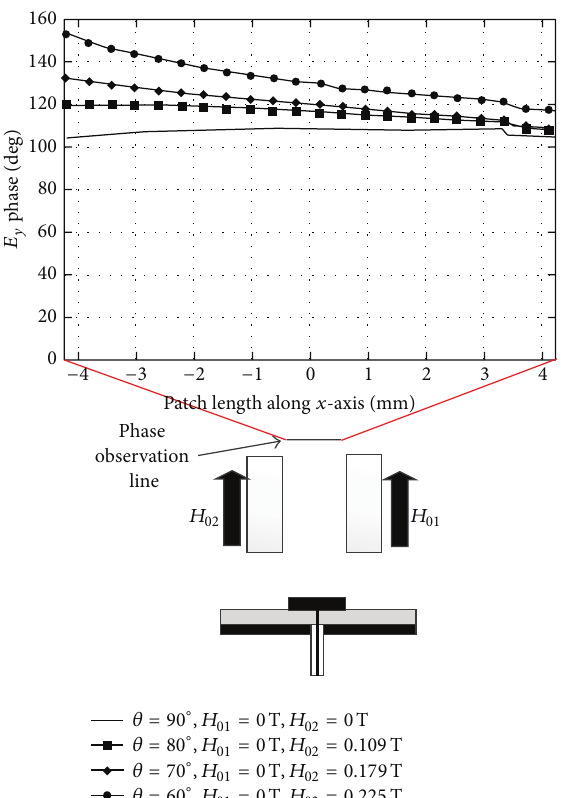
Figure 7: 𝐸 𝑦 phase distribution in the NF region for different scan angles.